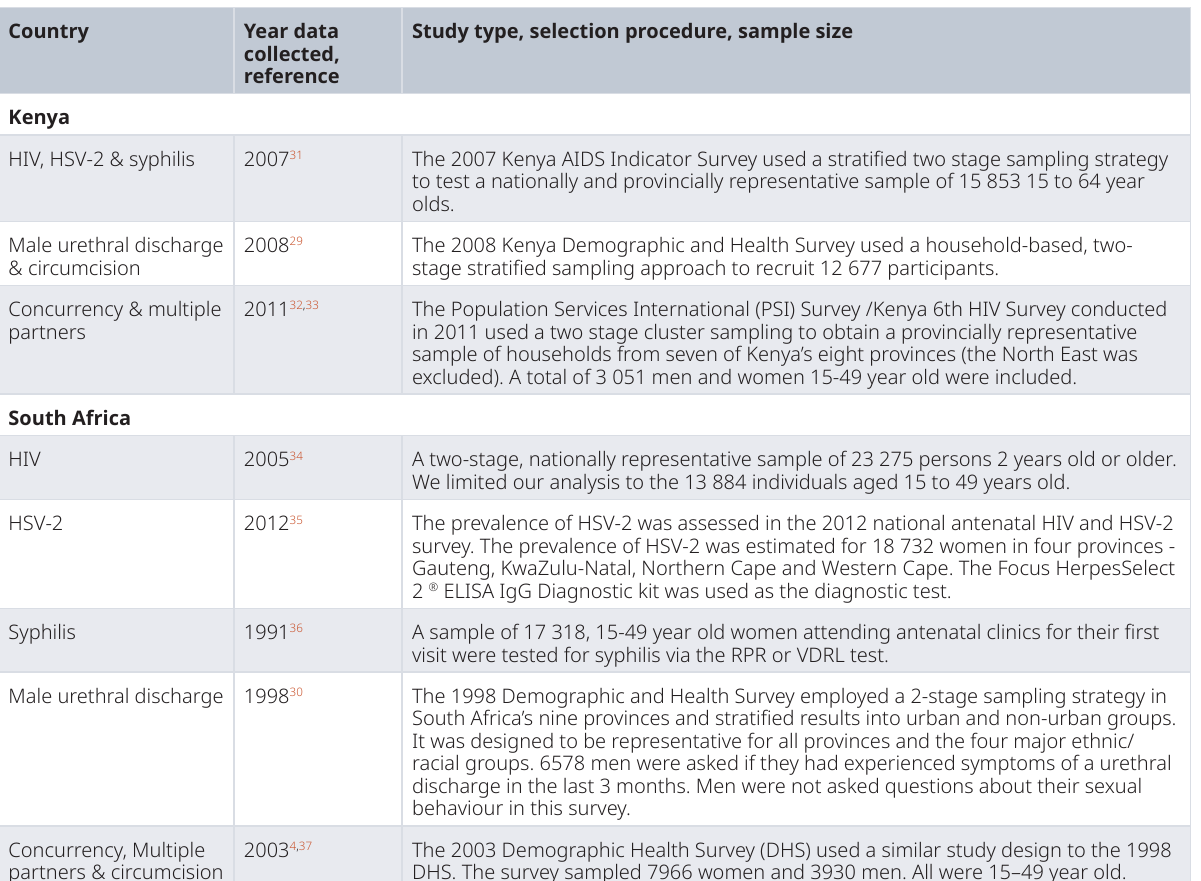
Table 1. Description of sources of data for comparison between ethnic groups: prevalence of STIs, multiple partners, concurrency. Country Study type, selection procedure, sample